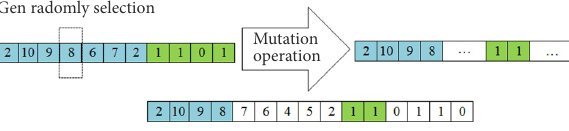
Figure 8. Example of the proposed mutation